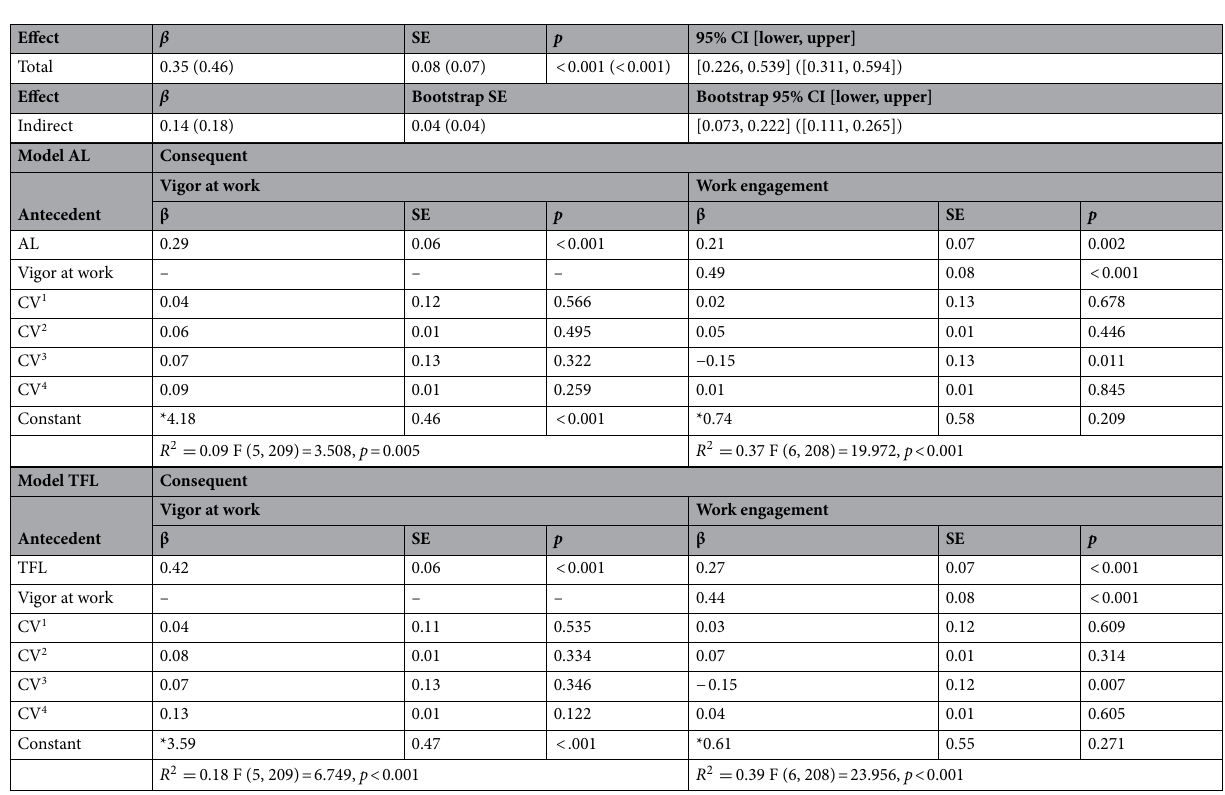
Table 3. Mediation models: Total, direct, and indirect effects and relationships among model variables. In the effect row, the values outside the parentheses are those from the AL model, whereas values in parenthesis pertain to the TFL model. Bootstrap = 5.000. β = Standardized coefficient; CI = Confidence interval; CV = Control variable; CV 1 = Gender; CV 2 = Age; CV 3 = Sector; CV 4 = Tenure in the organization; SE = Standard error; AL = Authentic leadership; TFL = Transformational leadership. * Unstandardized coefficient.